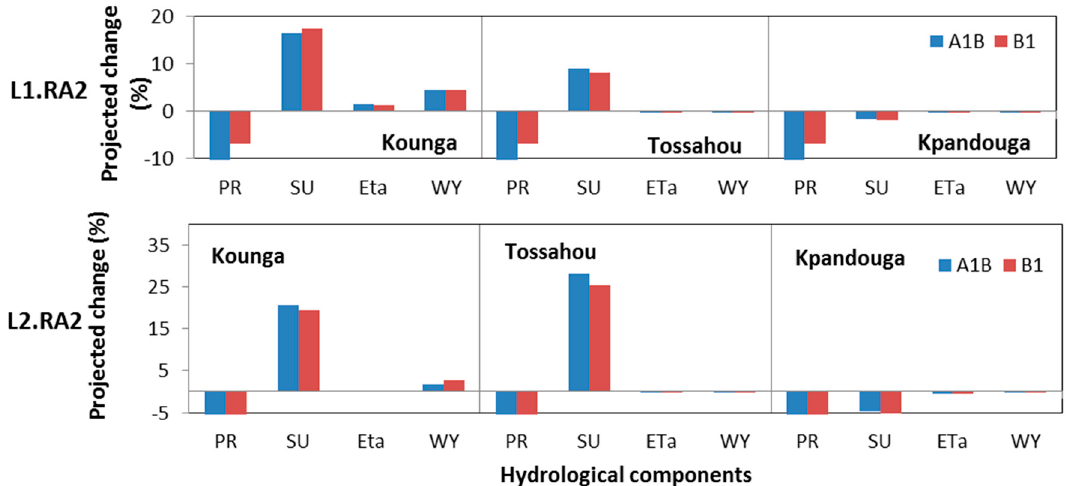
Figure 9. Relative changes induced by the development of the rainfed-bunded cultivation system compared to the current cultivation system with no use of fertilizers under land use and climate change scenarios from 2030 to 2049. L1 and L2 are land use change scenarios of 25% and 75% lowland conversion, respectively. RA2 is rainfed-bunded rice cultivation system with no fertilizer application. A1B and B1 are climate change scenarios; ETa is actual evapotranspiration; PR is precipitation; SU is surface runoff; and WY is total water yield.